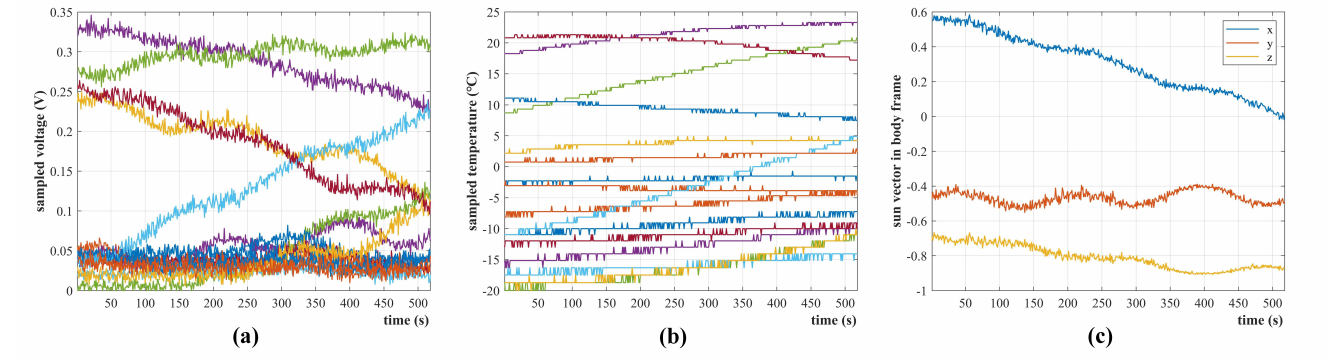
Figure 18. Raw measurements of IPSS extracted from the real − time telemetry data from 25 March 2021 03:04:45 UTC to 03:13:22 UTC. ( a ) sampled voltage curves of the 16 solar cells. ( b ) sampled temperature curves of the 16 solar cells. ( c ) the inversed sun vector in the satellite body frame by Q-SAT.